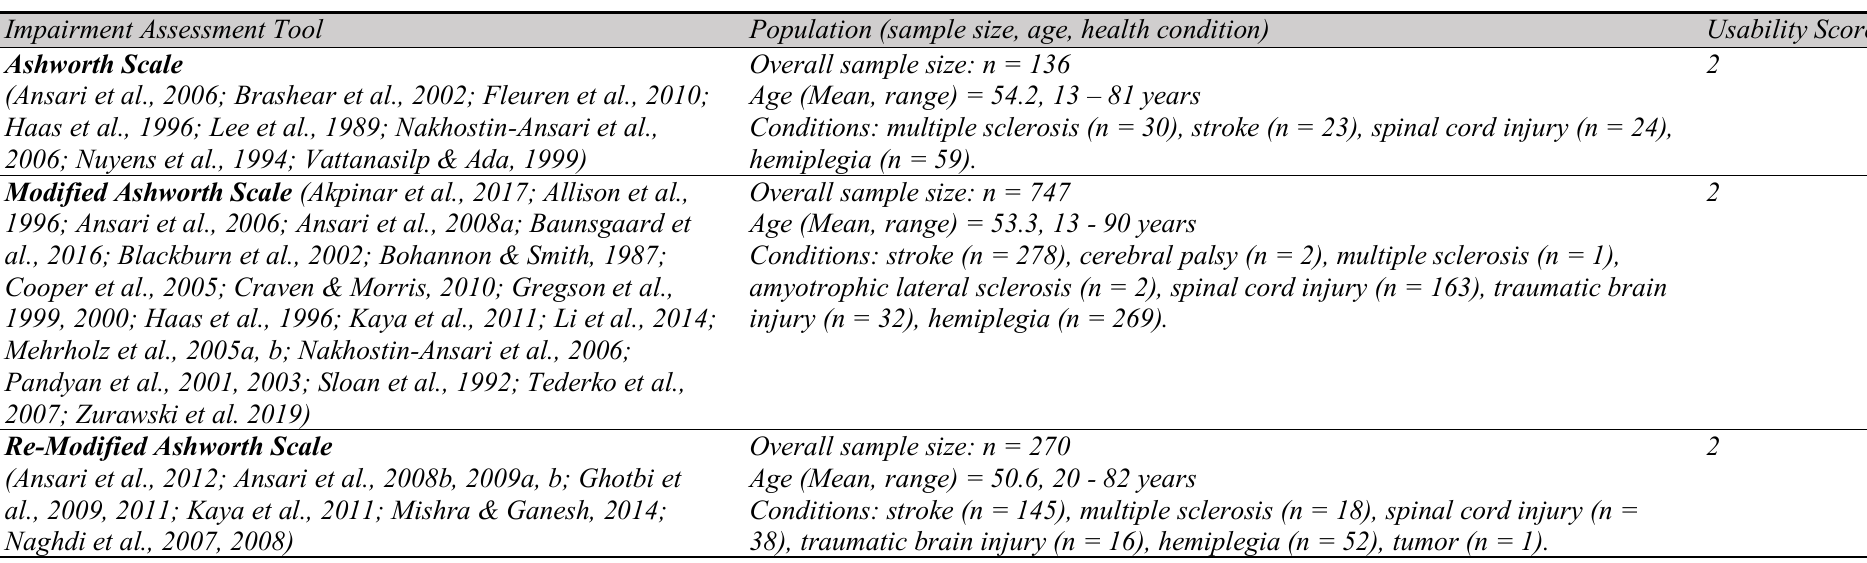
Table 3. Details of included scientific articles, populations studied, and the usability score for selected impairment assessment